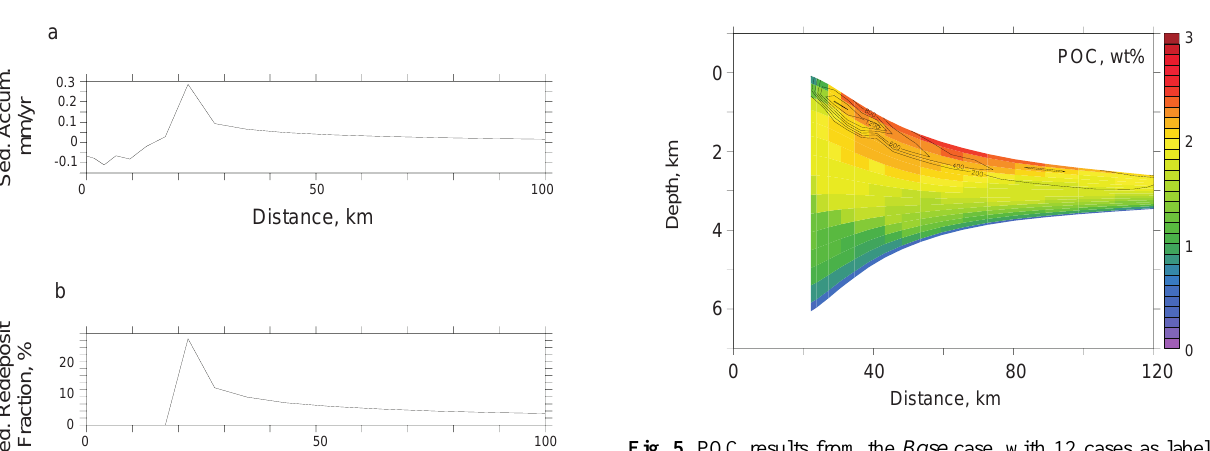
Fig. 5. POC results from the Base case, with 12 cases as labeled plotted in Fig. 5 Supplement. Contours are respiration rates. Results from other scenarios can be seen in the Supplement file poc.pdf, and a movie of the Base and Bumpy simulations can be seen at http://geosci.uchicago.edu/ ∼ archer/spongebob active/poc.active.